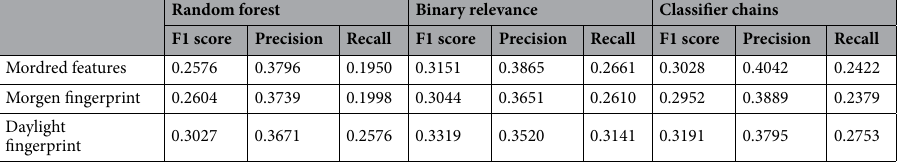
Random forest Binary relevance Classifier